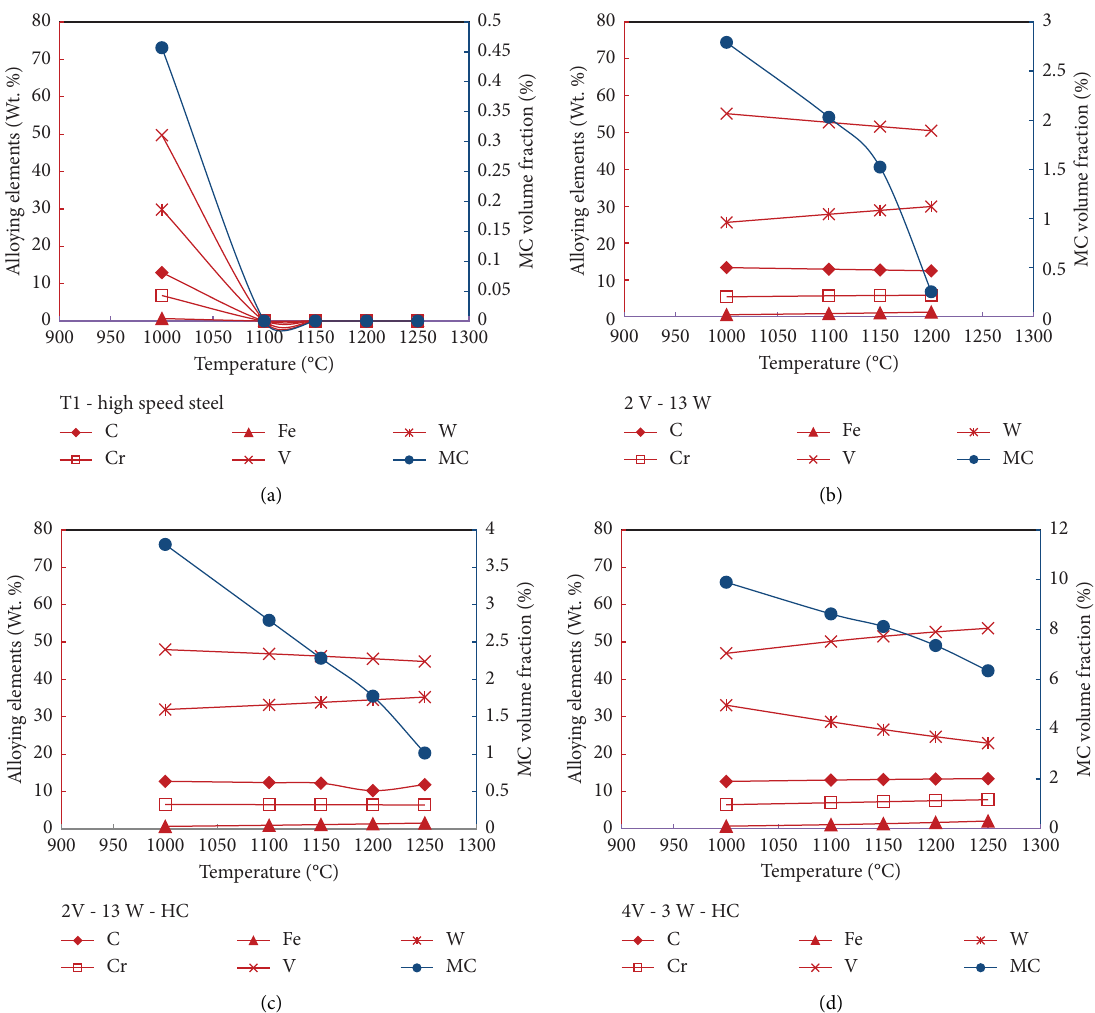
Figure 14: Chemical composition and the volume fraction of MC carbide presented in investigating steel at diferent austenitization temperatures. (a) T1 high-speed steel, (b) 2V-13W, (c) 2V-13W-HC, and (d)